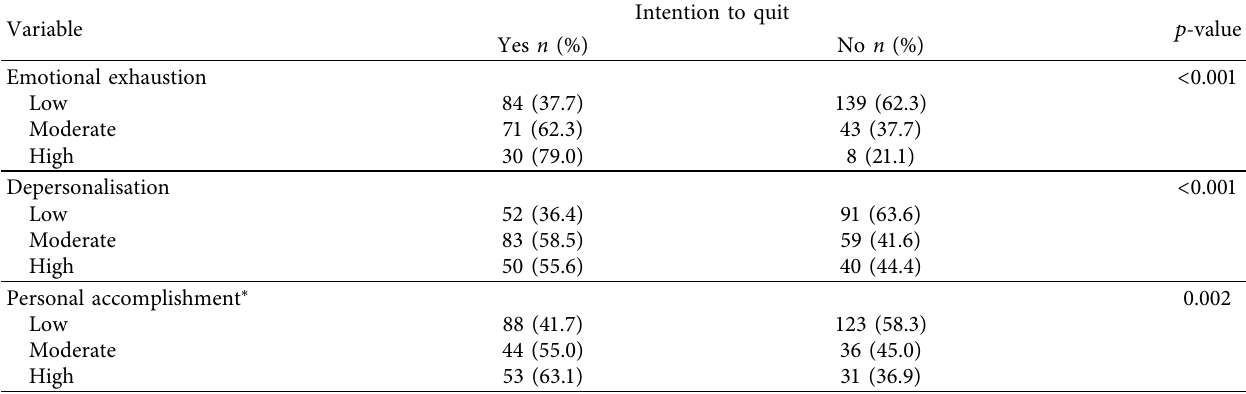
Table 3: Relationship between burnout and intention to quit among study participants.